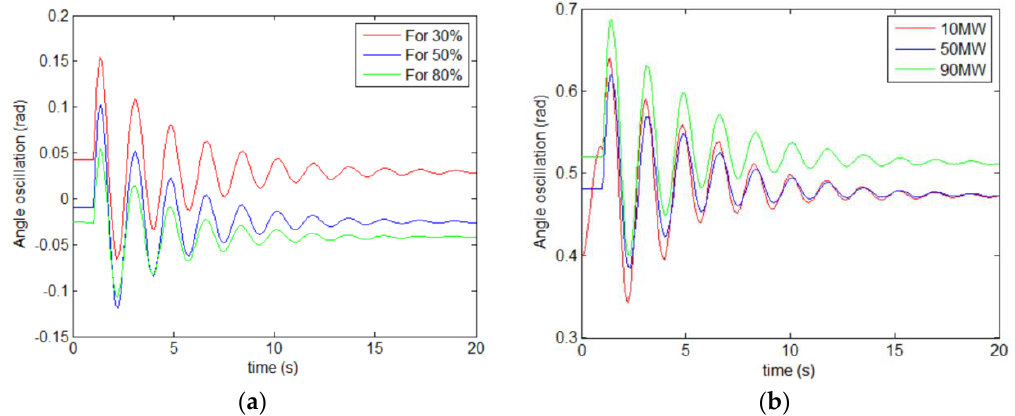
Figure 4. Power angle oscillation curves: ( a ) different compensation levels, and ( b ) different wind farm power outputs.